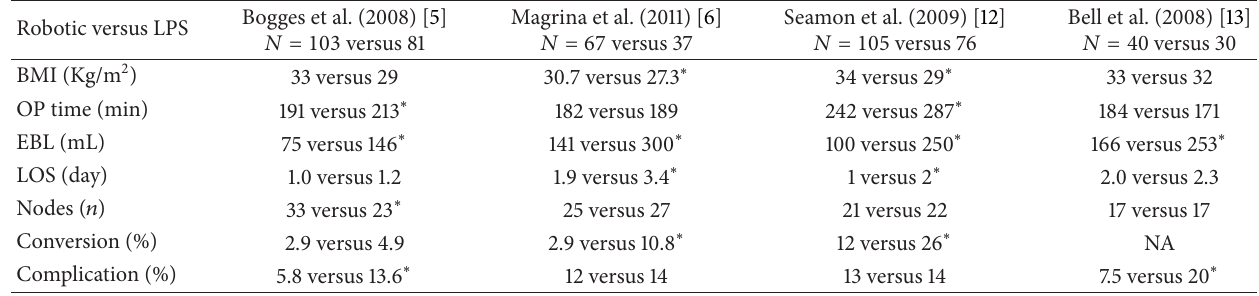
Table 7: Robotic versus laparoscopic hysterectomy and staging: endometrial cancer. Robotic versus